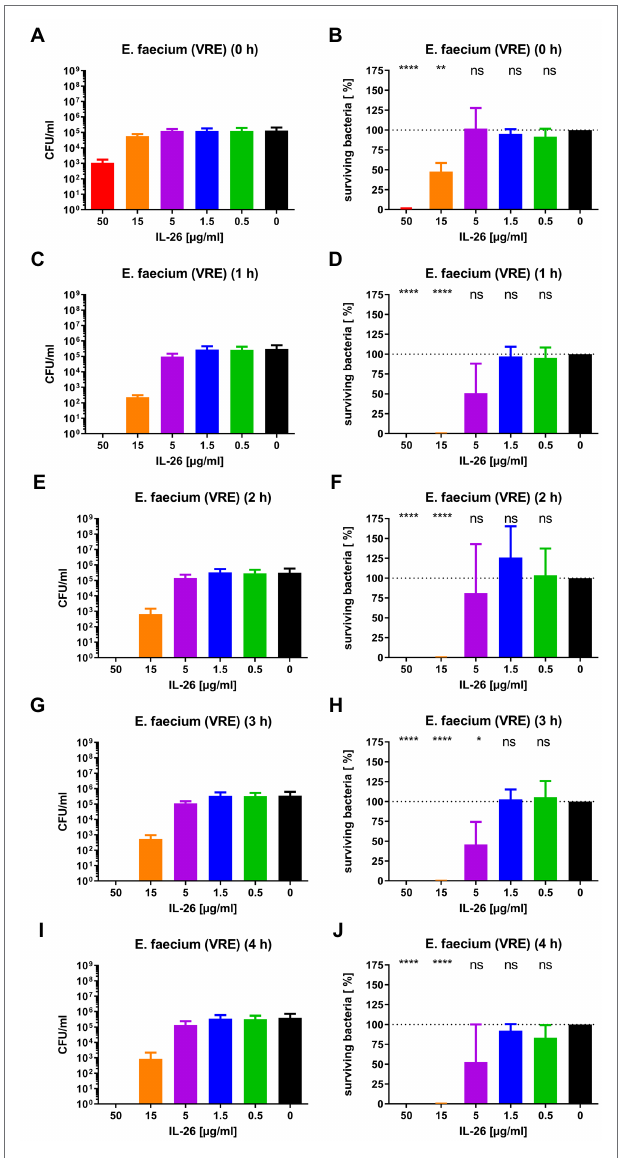
FIGURE 3 | Number of colony forming units per ml (A,C,E,G,I) and percentage of surviving bacteria (B,D,F,H,J) for vancomycin-resistant E. faecium DSM 17050 for different incubation durations and different IL-26 concentrations. * p ≤ 0.05; ** p ≤ 0.01; **** p ≤ 0.0001; ns = not significant; and independent two-sample t -test. Mean with standard deviation, n = 3. The colors refer also to Figure 2